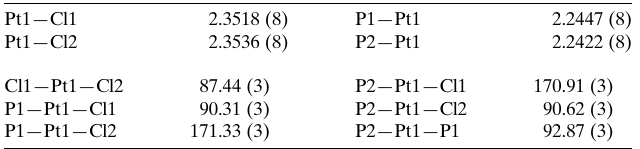
Table 1 Selected geometric parameters (A˚ , (cid:4) ).